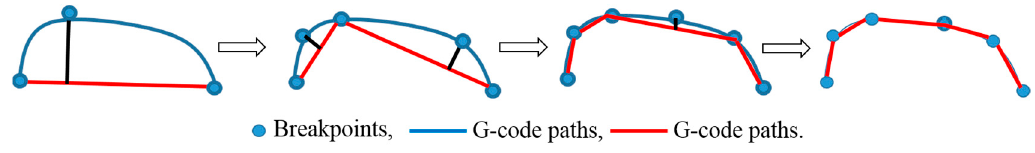
Figure 7. Encoding a toolpath into a series of G-codes.